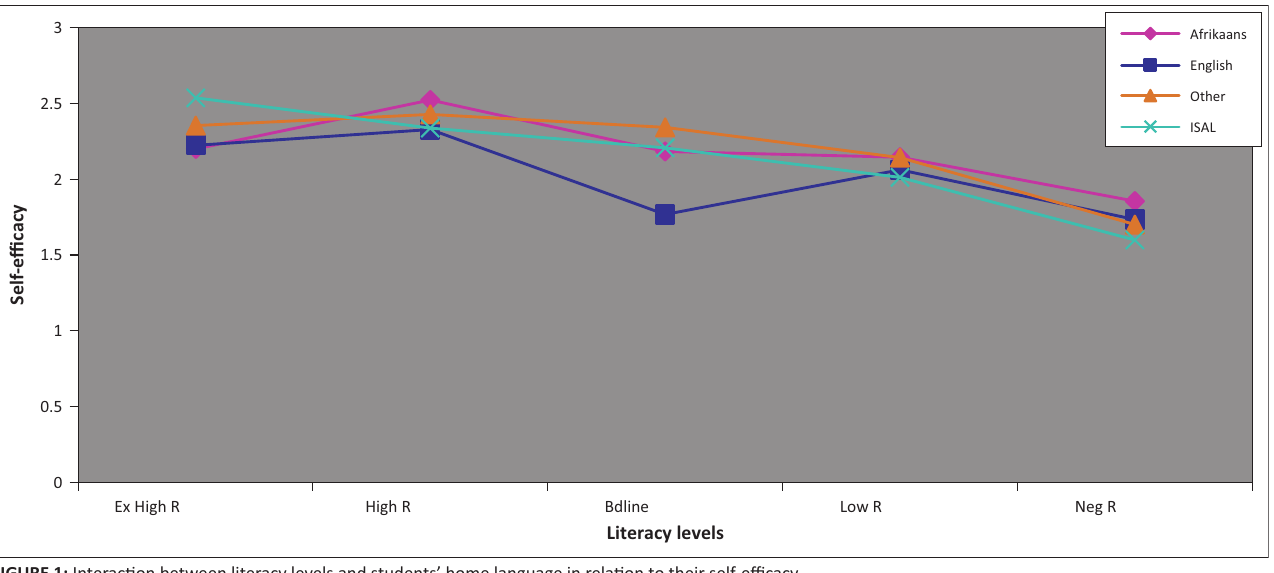
FIGURE 1: Interaction between literacy levels and students’ home language in relation to their self-efficacy.